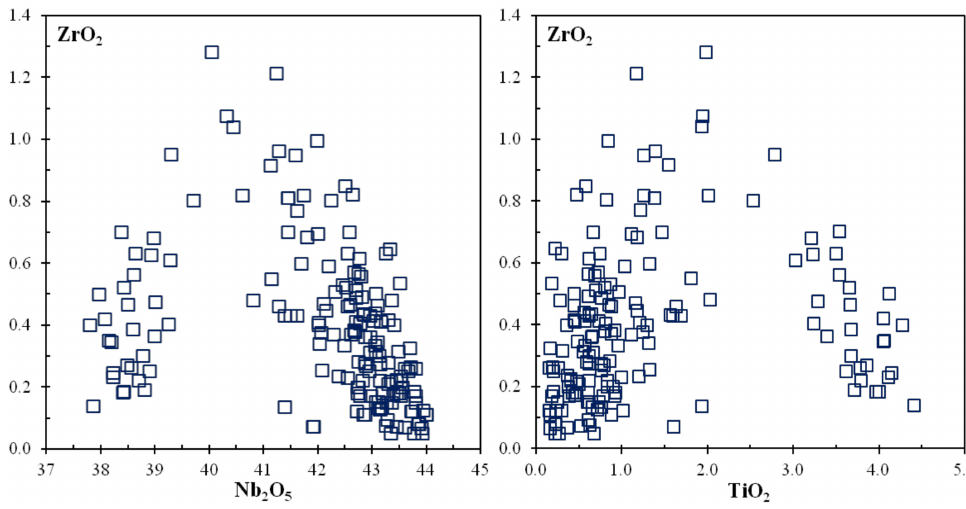
Figure 6. Variations of ZrO 2 versus Nb 2 O 5 and TiO 2 in rippite (in wt